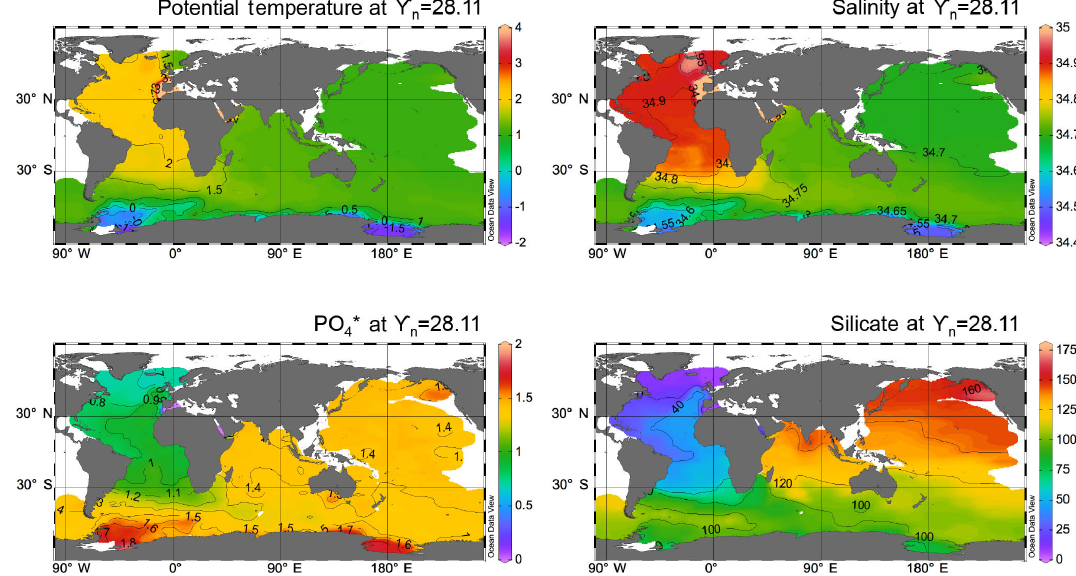
Figure A6. Potential temperature, salinity, PO ∗ , and silicate on the 28.3 isopycnal horizon. The depth of this horizon is shown in Fig. 8 and 4 averages ∼ 4000m in the basins and ∼ 400m in the mixed layer in the Southern Ocean. Data are from GLODAPv2 (Key et al., 2015; Olsen et al., 2016) with profiles, maps, and sections plotted in ODV (Schlitzer,